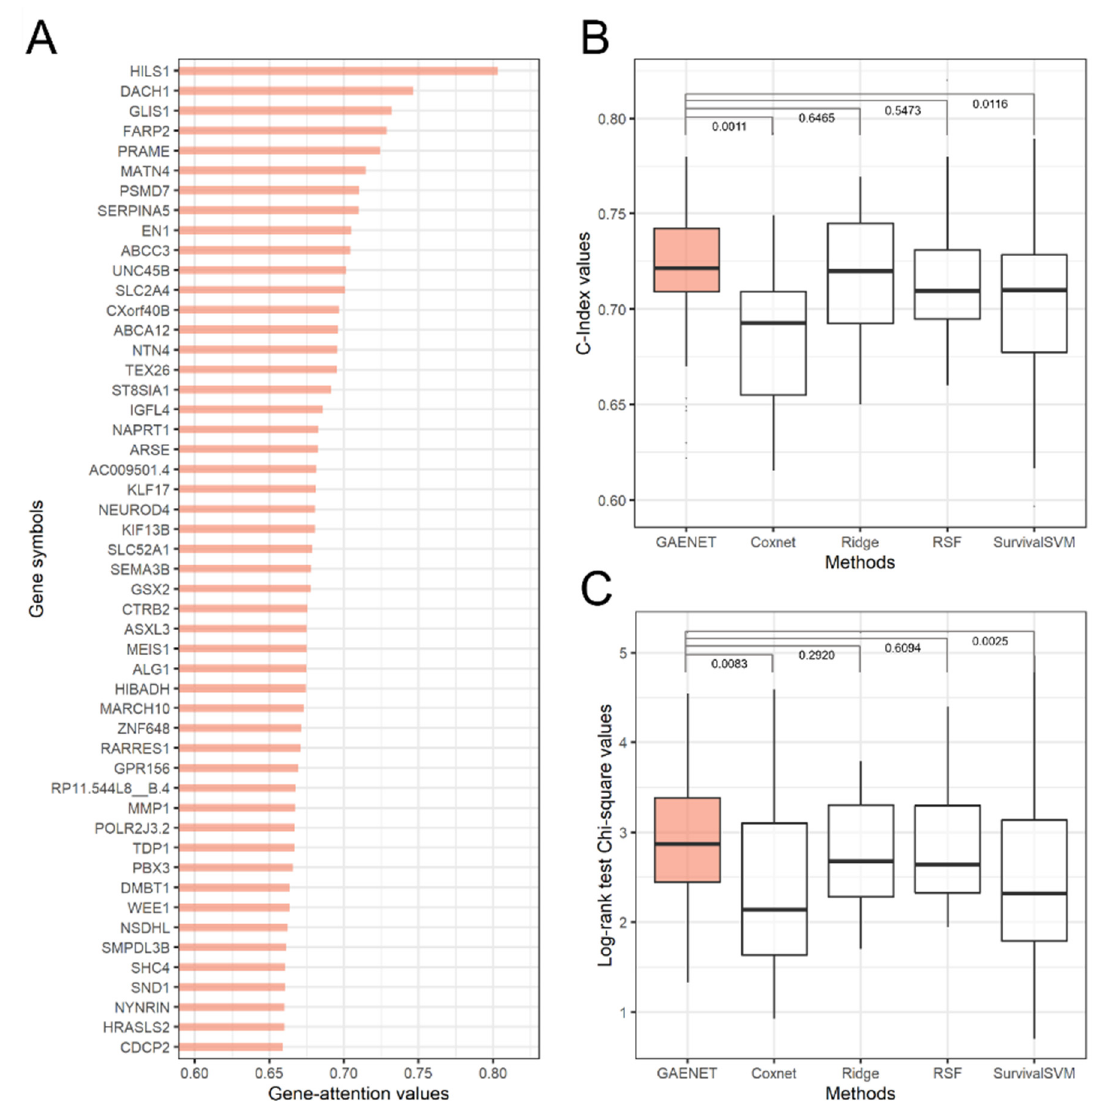
Figure 2. Prediction results of the GAENET. ( A ) Estimated prognostic genes for low-grade glioma. ( B ) Comparison of estimation performance with C-Index. ( C ) Comparison of estimation performance with the log-rank test. The estimated prognostic genes were discovered with test sets. The values above the boxplots are the Wilcoxon signed rank test p -values. The results of log-rank test are exhibited with square root values of Chi-square values. The estimation performances were measured with 30 times of cross-validations. The proposed gene attention algorithm ranked HILS1 , a pseudogene, as the most significant prognostic gene. The log-rank tests indicated that the proposed GAENET had a median χ value of 2.870, a difference of 7.2 percent from the second-best model, ridge regression.